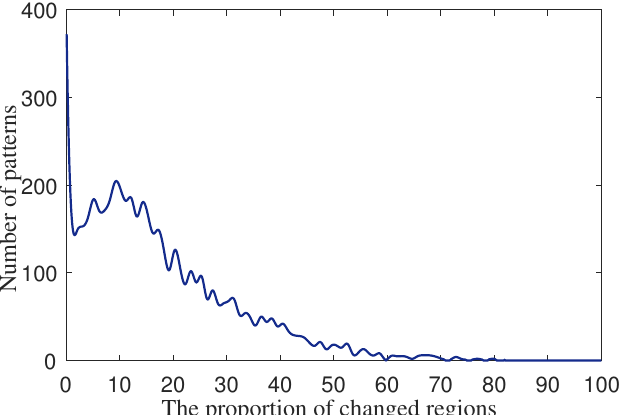
Figure 9. Dataset analysis. The ratio of the changed areas in each image in the data set to the